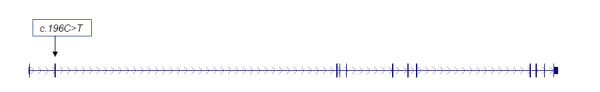
The BCO2 gene structure. The figure is showing the predicted gene structure of the ovine BCO2 gene, based on the bovine genomic sequence. The nonsense c.196C>T mutation is localized in the 2nd exon, assumed to produce a truncated protein of 65 amino acid residues (CAX63048), compared to 575 amino acid residues in the wild type version (CAX63047). The figure is modified from the UCSC Genome Browser.